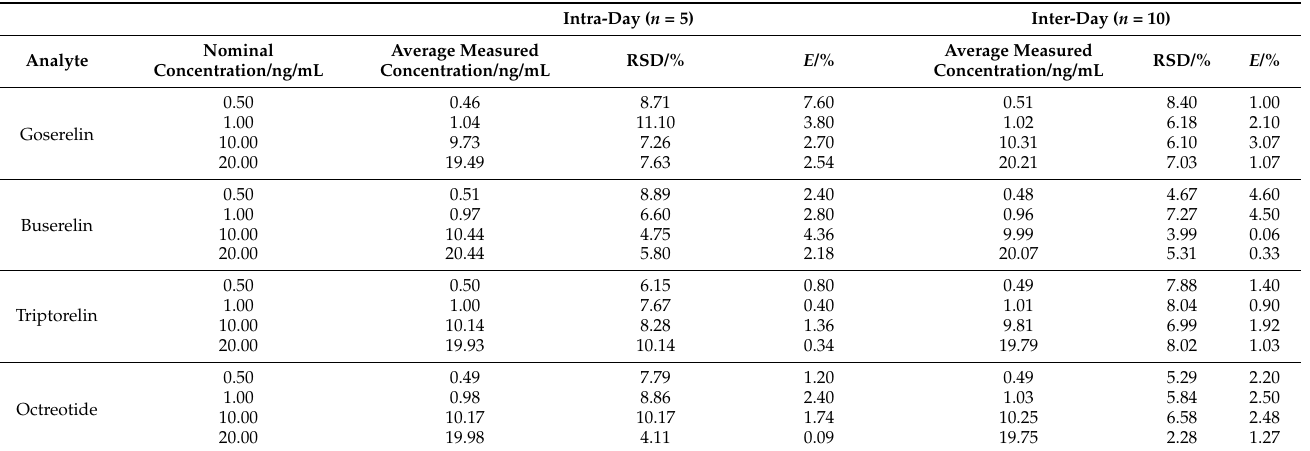
Table 2. Intra-day and inter-day accuracy and